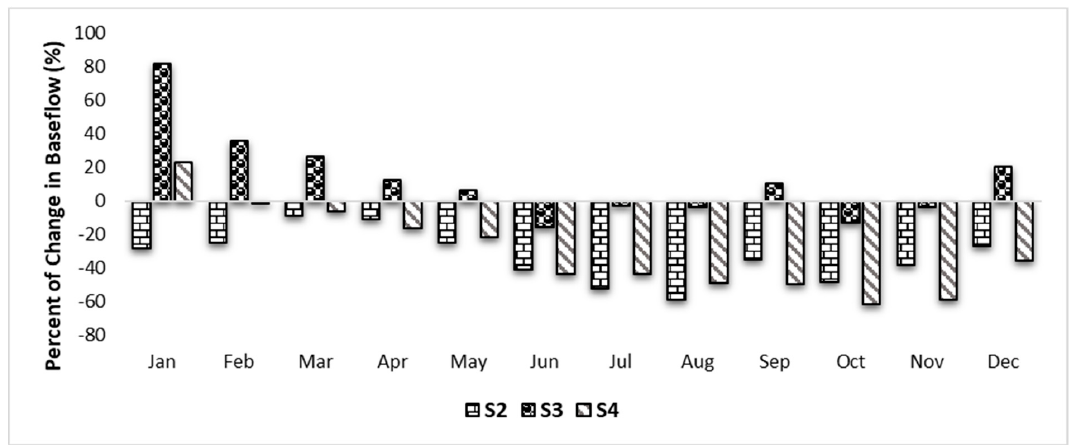
Figure 11. Relative change in average monthly baseflow in the LEC watershed.